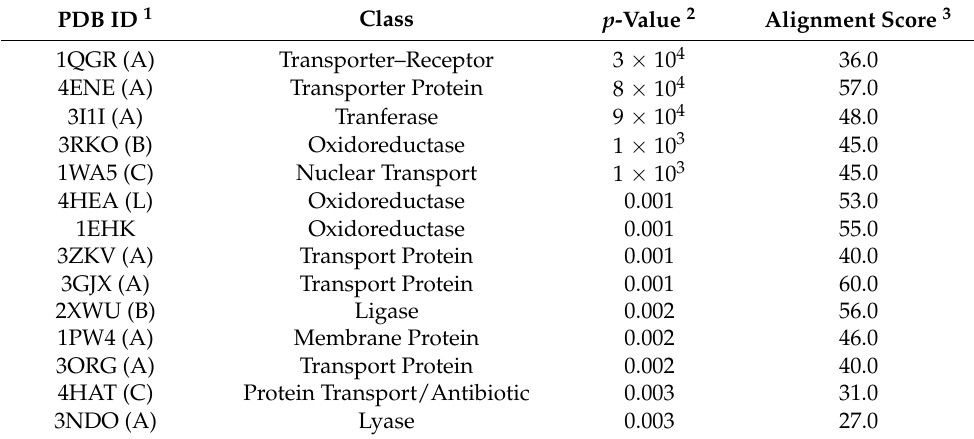
Table 1. Template hits obtained from pGenThreader analysis.